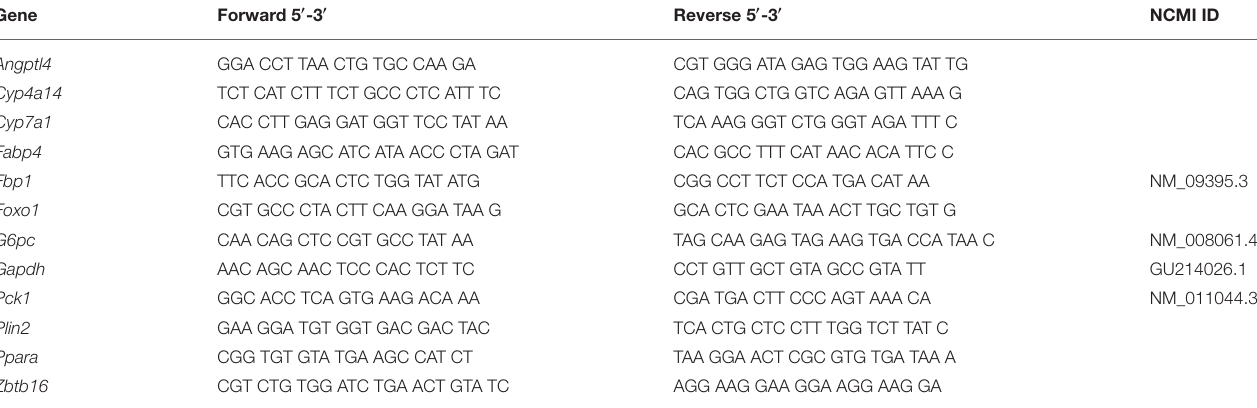
TABLE 1 | Sequences for qPCR